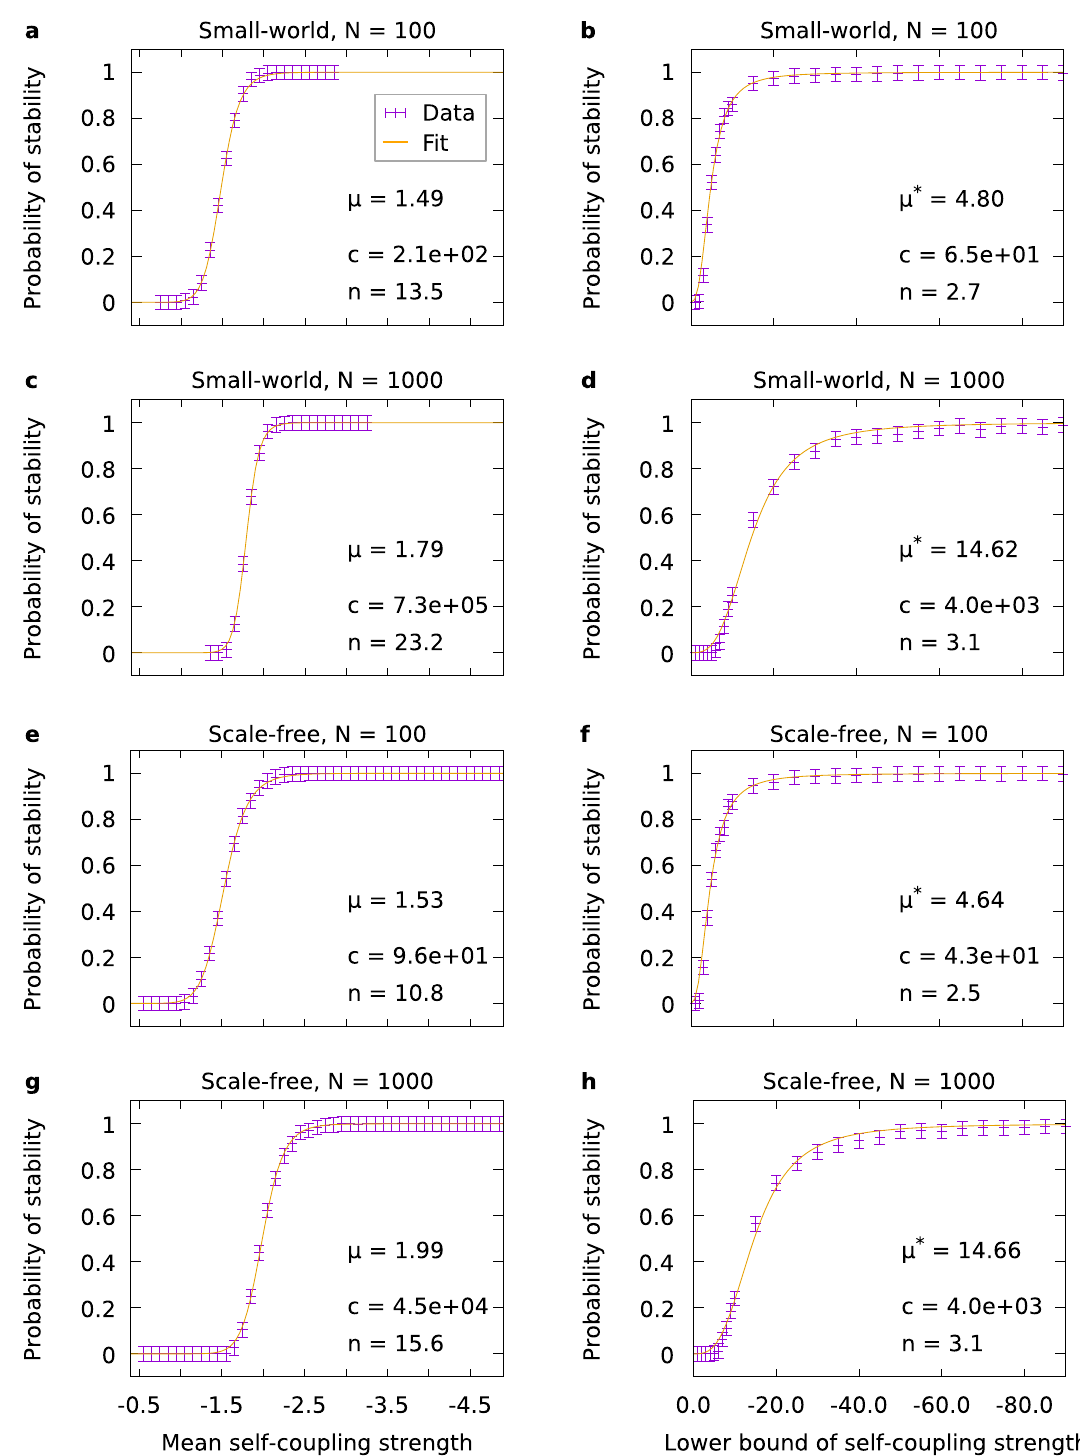
Figure 2. Examples of stabilization of small-world and scale-free networks. The stabilization parameter µ or 100 and N 1000 µ ∗ as well as the Hill fit parameters (cf. Eq. (1)) are given in the plots. Networks of sizes N = = are shown. For each data point, the probability was averaged over 1000 trials. Error bars indicate the standard deviation estimated as described in “Methods”. ( a , c , e , g ) The probability of stability is plotted over the mean self-coupling strength. The self-coupling strengths were drawn from intervals of varied position but fixed size 0.9 (see main text). ( b , d , f , h ) The probability of stability is plotted against the lower bound of the self-coupling strength. The self-coupling strengths were drawn from an interval with lower bound varied and upper bound 0.4 . Small-world networks in ( a – d ) were generated with k nn 4, p rew 5% , scale-free networks in fixed at − = = 2, m 0 0 (see (e-h) were generated with m = =